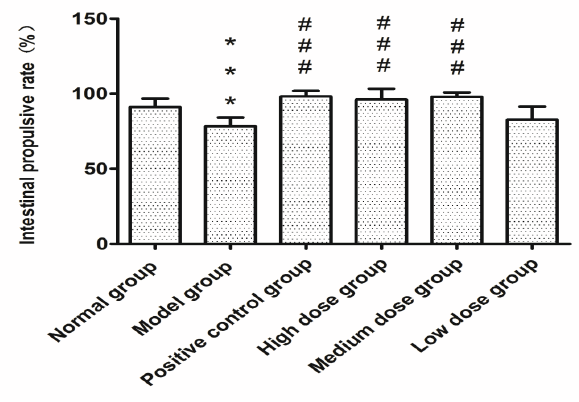
Fig. 4a Intestinal propulsive rate Figure 4a: Intestinal propulsive rate.